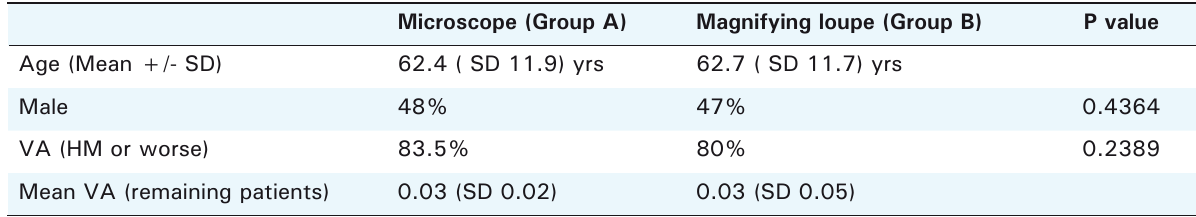
table 1. baseline characteristics